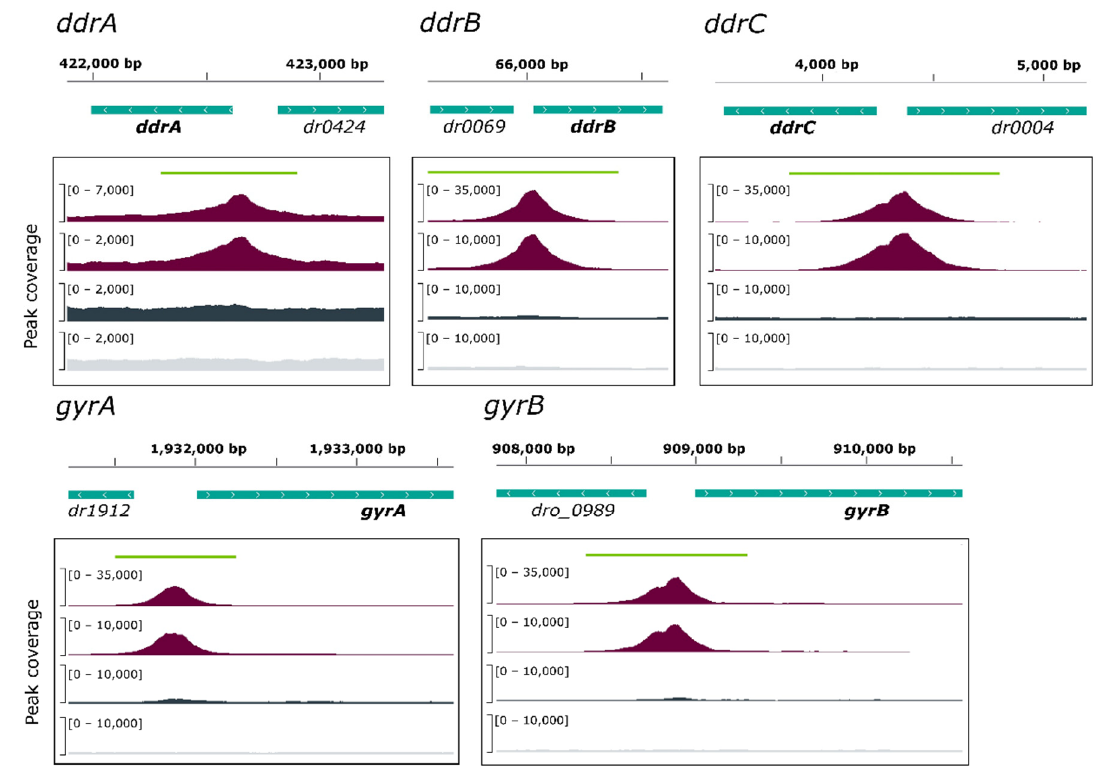
Figure 2. Visualization, through IGV, of the binding peaks obtained from genome analysis. Tag density profiles are illustrated for 2 IP (purple), the Input (dark grey), and the Mock (light grey) for five known DdrO-regulated genes: ddrA , ddrB , ddrC , gyrA , and gyrB. The green lines indicate the size of each peak identified by bPeaks. Genes are represented by green boxes, their location on either strand is indicated by > (strand +) and < (strand − ). The genomic coordinates of each locus are indicated on the X -axis. dro_0898 is split into two CDS (DR0903-DR0904) in the White et al. annotation [48].